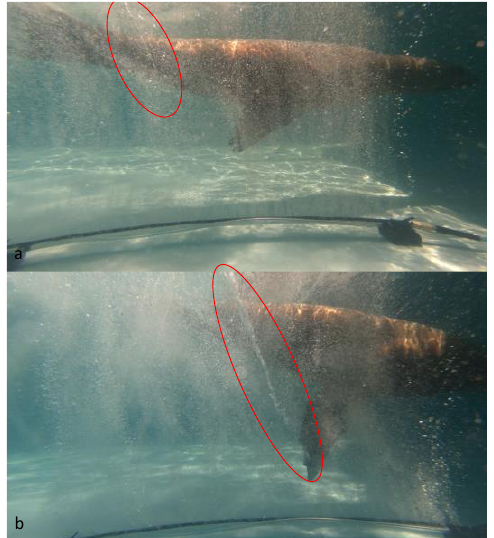
Figure 6. The top panel ( a ) shows the raw data used to produce Figures 5e and 7e, and the bottom panel ( b ) is a similar phase in another data run. Both show a trailing vortex structure (red circle) resulting from the sea lion’s propulsive stroke.